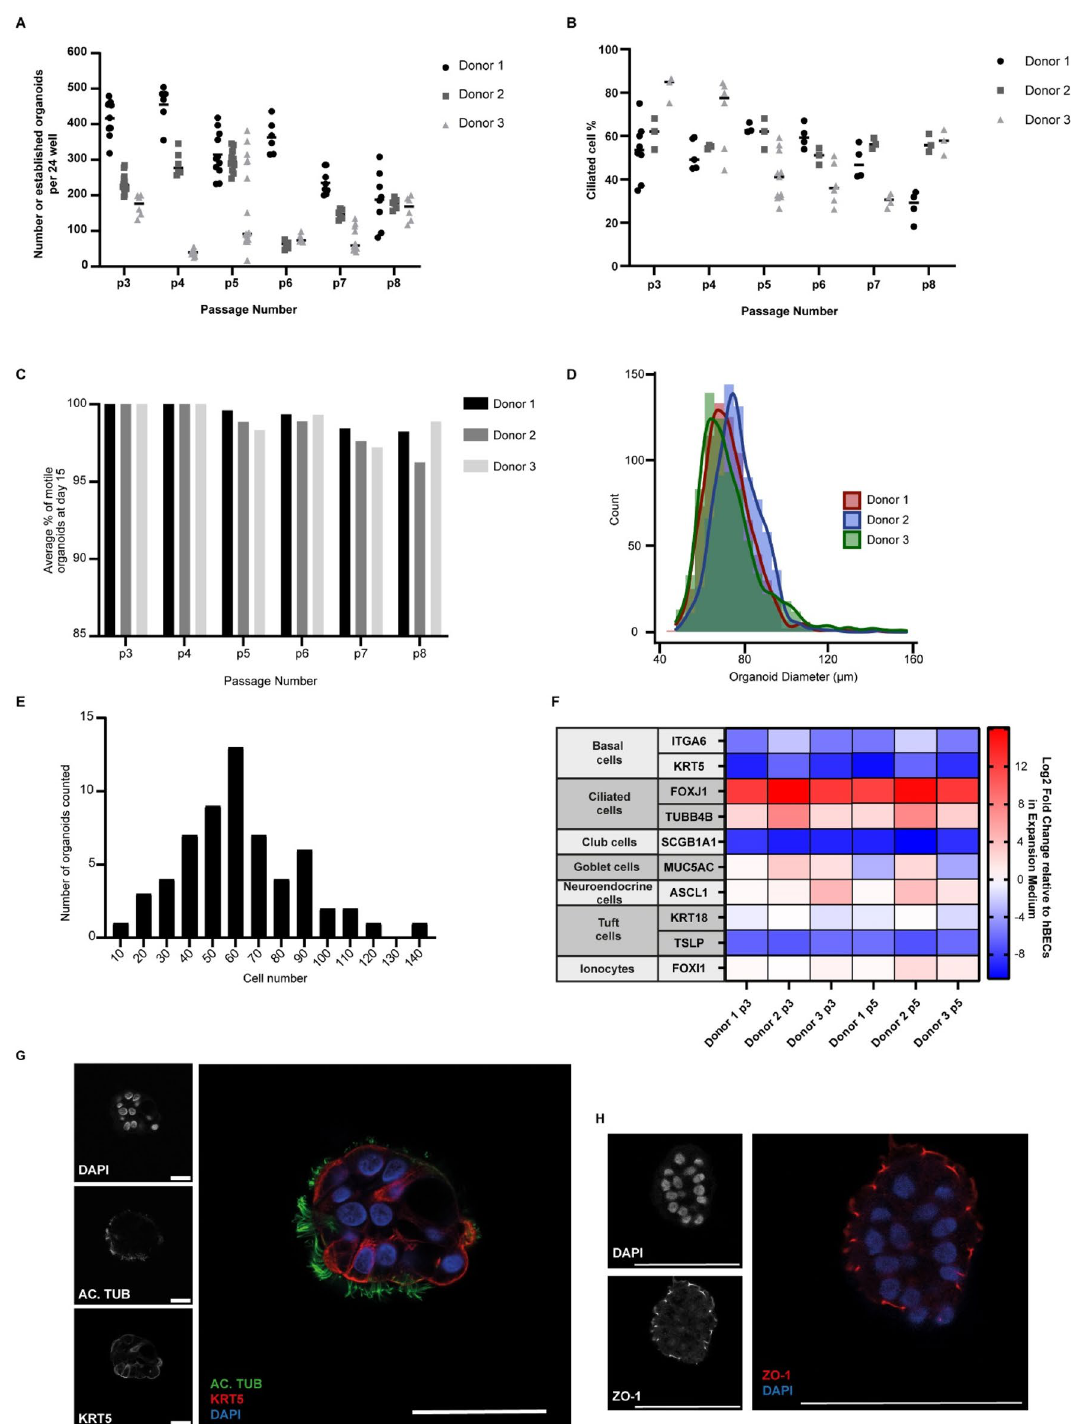
Figure 2. Characterisation of apical-out airway organoids. ( A ) Number of generated organoids per well of a 24-well tissue culture plate plate across three different donors and multiple passages. Data points represent independent wells of a 24-well plate (n = 3). ( B ) Ciliated cell percentage of generated apical out organoids at day 15 across multiple passages. Data points represent measurements taken from independent wells of a 24-well plate (n = 3). ( C ) Percentage of organoids counted for panel ( A ) that displayed motile cilia on the outside at day 15 across three different donors and multiple passages. Organoids were classified as ‘motile’ when displaying sufficient cilia to cause motion of the organoid. ( D ) Histogram depicting the frequency of different Feret diameters in p3 Ap-O AO from 3 donors. 750 organoids were equally counted from 3 wells for each donor. ( E ) Histogram depicting the frequency of measured DAPI-positive cells in each organoid. In total 60 p3 organoids were counted. ( F ) Fold changes in the RNA levels of common differentiation markers in Ap-O AO across 2 different passages in three donors. Results were normalized against p3 hBECs cultured in PneumaCult-EX Plus (n = 3). ( G ) Expression of AC. TUB (green) and KRT5 (red) in Ap-O AO. Nuclei are visualized with DAPI (blue). Single channels are depicted in grayscale (scale bars = 50 μm). ( H ) Expression of ZO-1 (red) in Ap-O AO. Nuclei are visualized with DAPI (blue). Single channels are depicted in grayscale (scale bars = 50